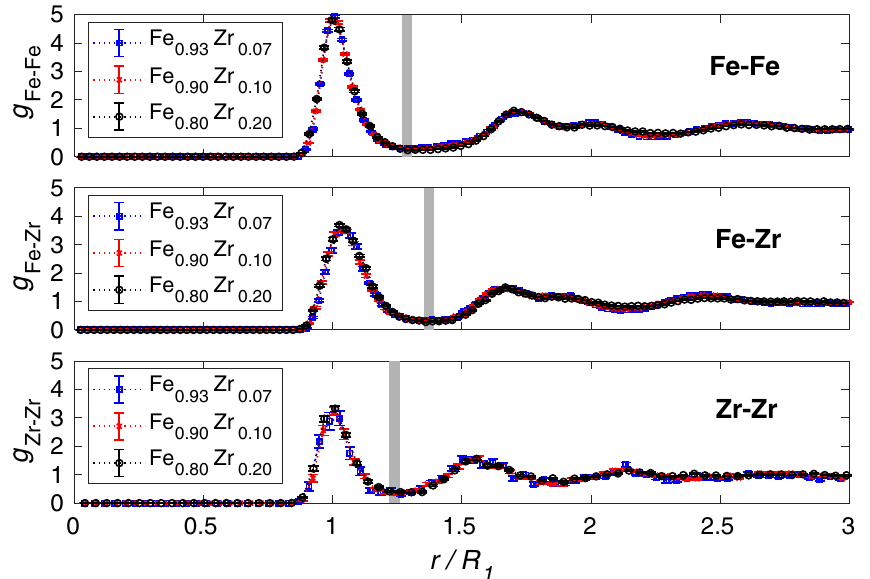
Figure 3. Partial radial distribution functions (RDFs) obtained from the simulated atomic positions for Fe-Fe, Fe-Zr, and Zr-Zr pairs versus r / R 1 . The R 1 values are reported in Table 2. The thick gray vertical lines indicate the limit of the first coordination shells.